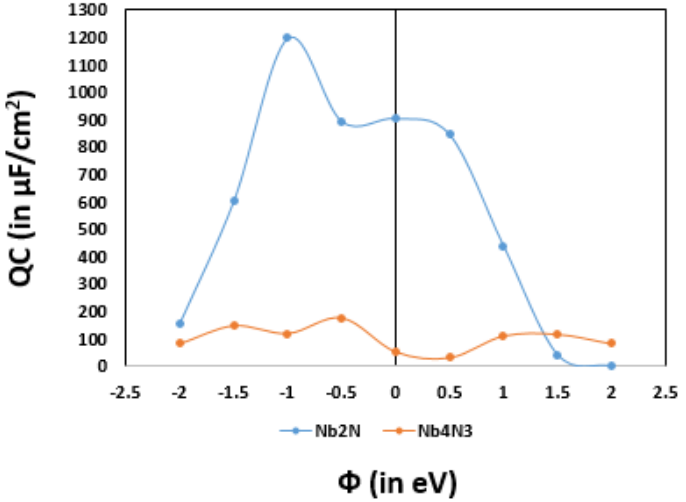
Figure 4. Variation in quantum capacitance (QC) for pristine unpolarized niobium nitride structures under bias voltage.